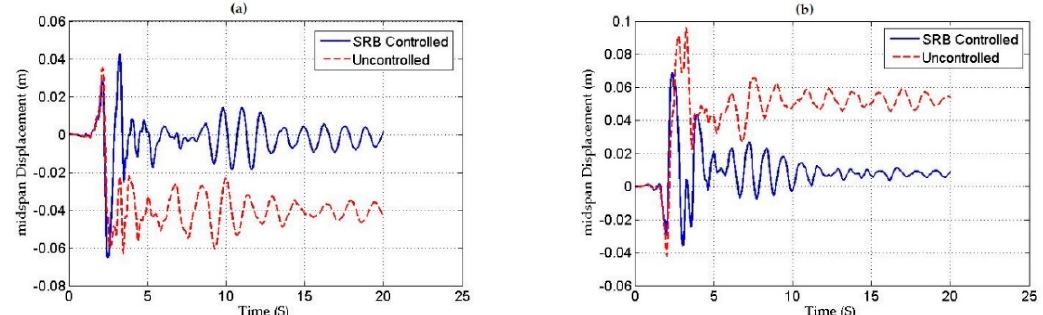
Figure 10. Time history curve of the mid-span displacement under far-field North Palm Springs in the ( a ) X and ( b ) Y directions.